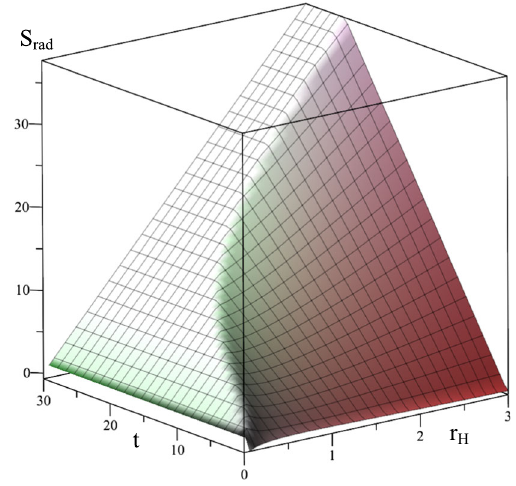
Fig. 5 Page curves as a function of time t and radius r H for a 0 = 1 and c = 1 .